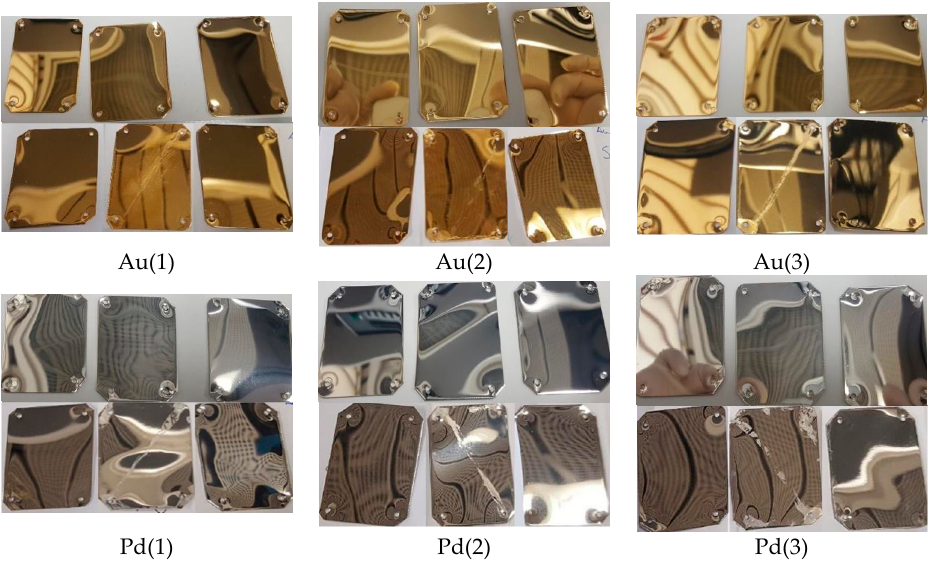
Figure 3. Pictures of all the samples taken before and after the chemical corrosion tests. The three top images in each cell correspond to the before, while the after is on the bottom, the performed tests from left to right are: dump heat, salt spray and sulphur dioxide.